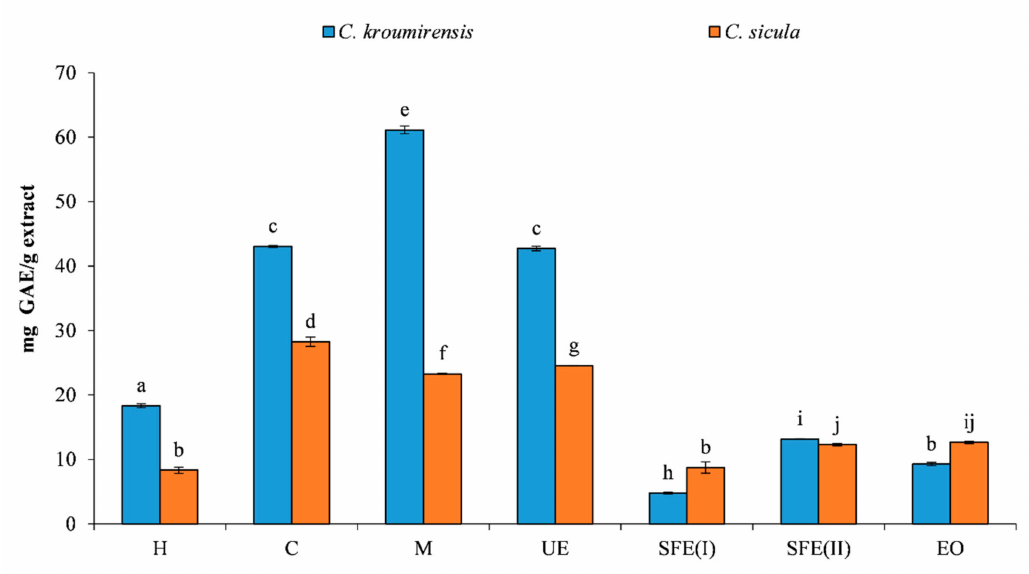
Figure 1. Total phenolic content (mg GAE / g) in extracts obtained from aerial part of two Centaurea species ( C. kroumerienis and C. sicula ) with di ff erent extraction techniques (Di ff erent letters indicate significant di ff erence ( p <